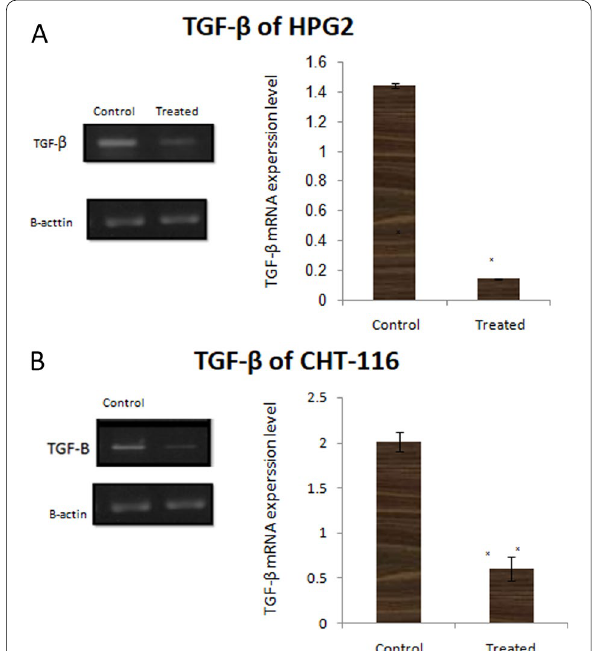
Fig. 10 PCR detected the expression of TNF‑α in HepG2 and HCT‑116 cells after treatment with NSP where the internal control expressed by the β‑actin gene. In each illustrative experiment data represent means SE performed in triplicate. *represents significantly ± dissimilar results (P < 0.05)